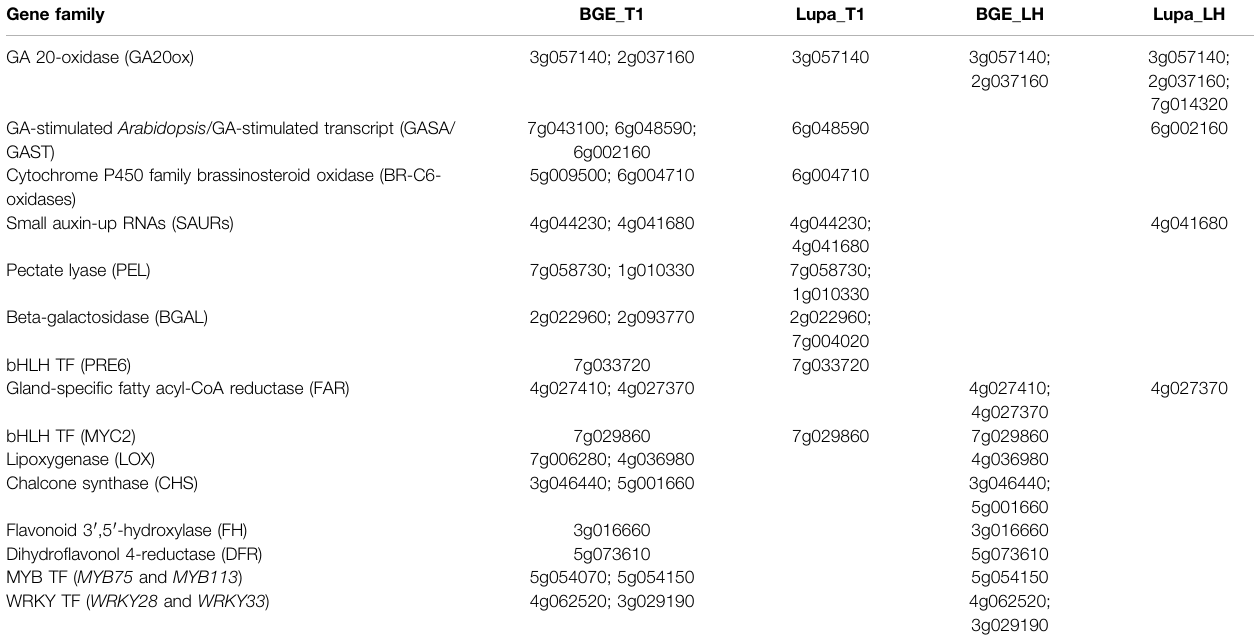
TABLE 2 | DEGs and their corresponding gene numbers from the L. culinaris cv. CDC Redberry reference genome (v2.0) were used for the proposed model in Figure 5 regarding their roles and interactions on elongation growth and defense response under low R/FR-induced shade conditions for both L. orientalis BGE 016880 and L. culinaris cv.